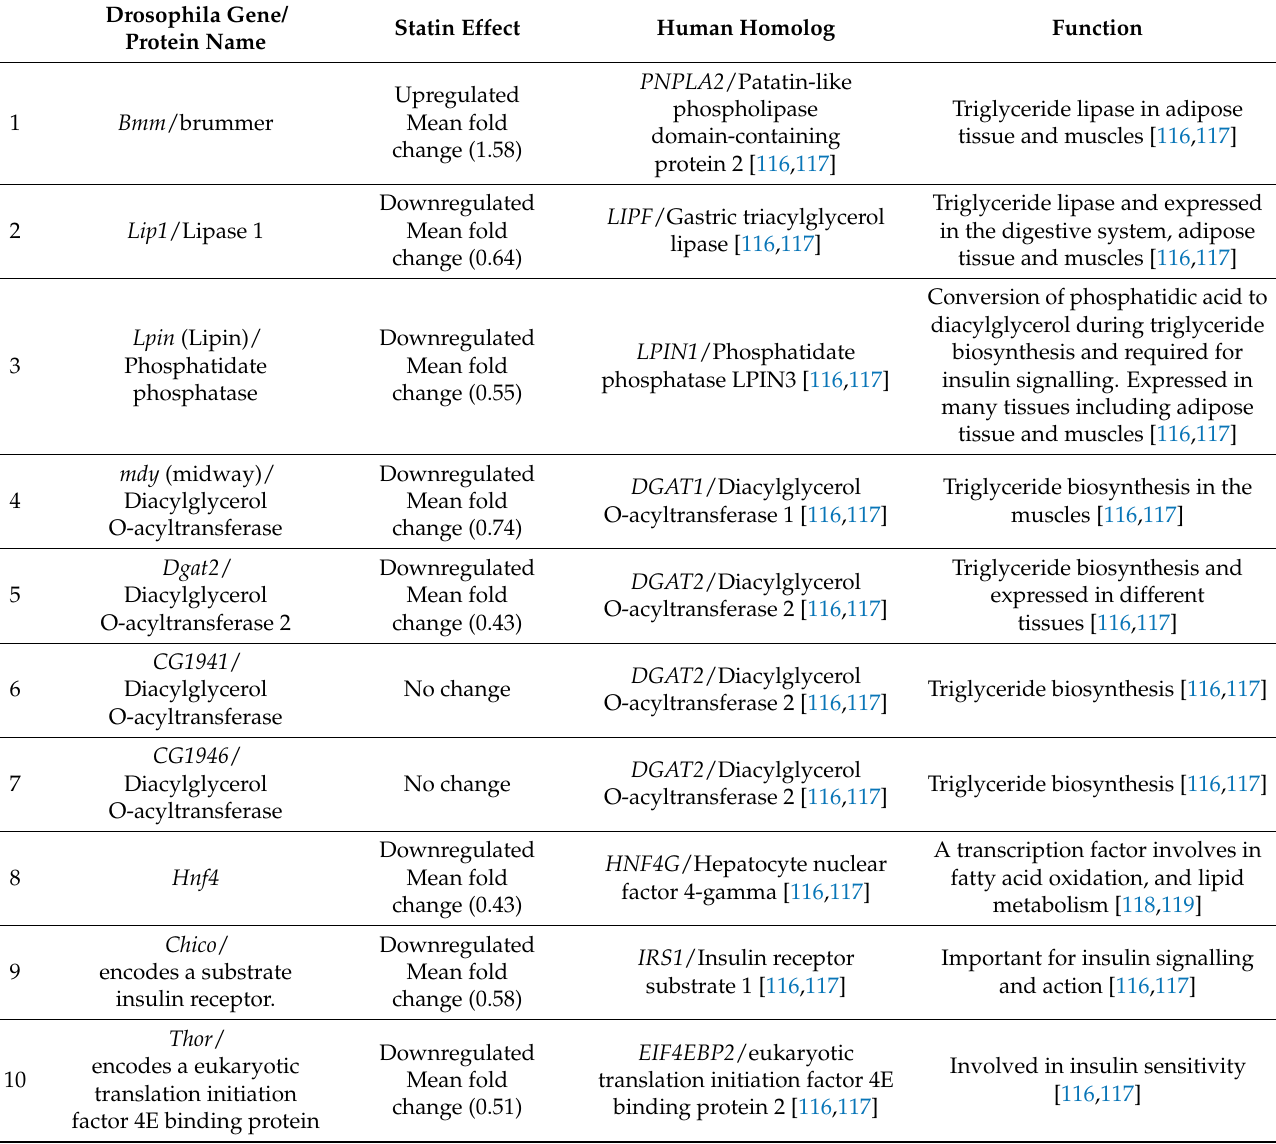
Table 7. Effects of chronic fluvastatin treatment on the transcription of important genes involved in lipid metabolism and insulin